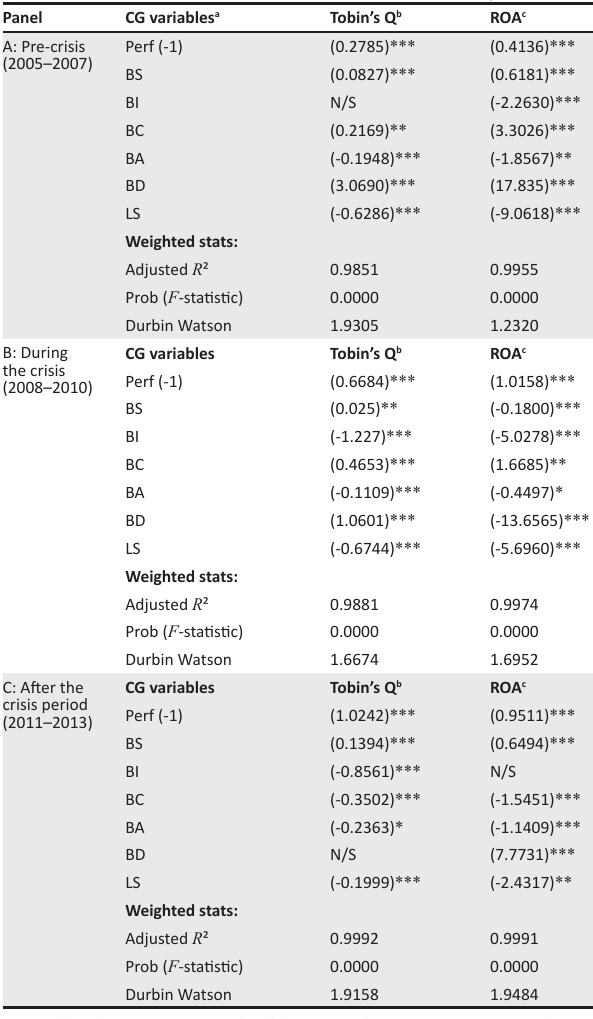
Note: Table 3 shows regression results of the impact of corporate governance attributes on Tobin’s Q and ROA for the consumer services industry. Column 1 shows the corporate